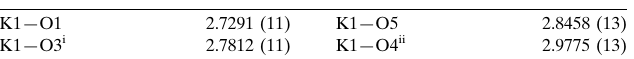
Selected bond lengths (A˚ ).